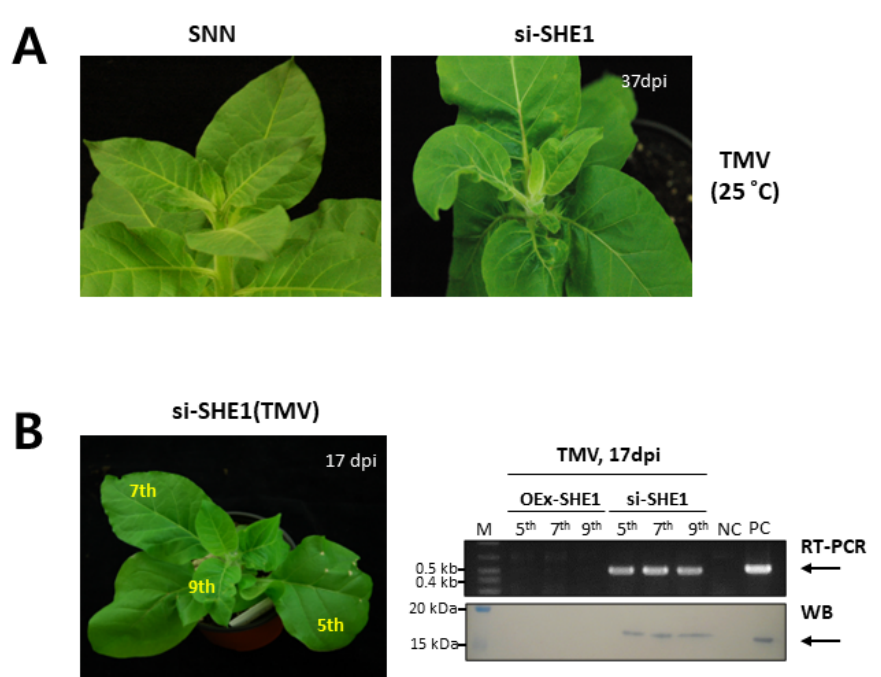
Figure 4. Systemic infection of nontransformed and transgenic plants silenced for expression of SHE1 inoculated with TMV. ( A ) Transgenic tobacco cv. Samsun NN si-SHE1 plants inoculated with TMV were maintained for the time indicated for 37 dpi. ( B ) Assay for TMV accumulation in the 17 dpi infected plant on the left, by either RT-PCR for TMV RNA ( CP gene; upper right) or Western blot analysis for TMV coat protein (lower right). Black arrows indicate the position of the expected PCR-sized product (523 bp) and the virus CP. TMV-infected plants were photographed under daylight conditions.